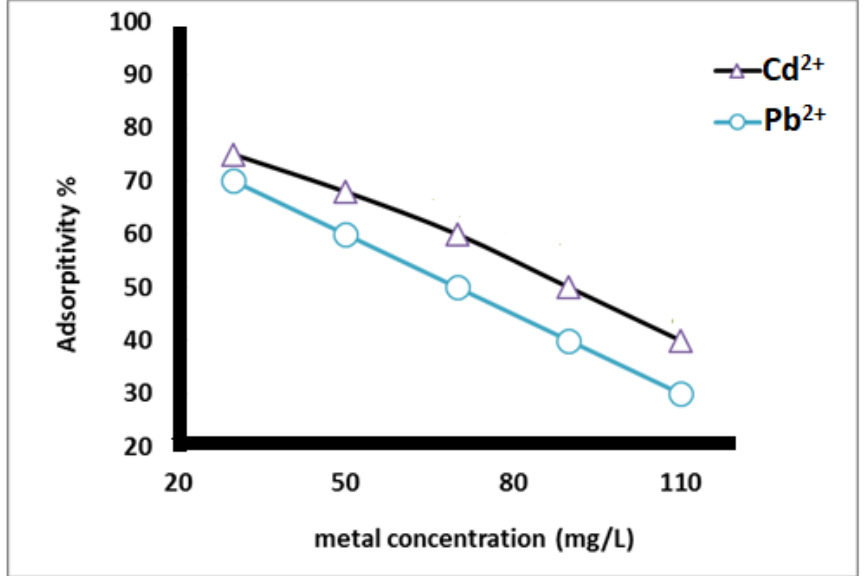
Figure 8. Adsorption % of heavy metal using different concentration of heavy metal ions at pH 5 and contact time 2